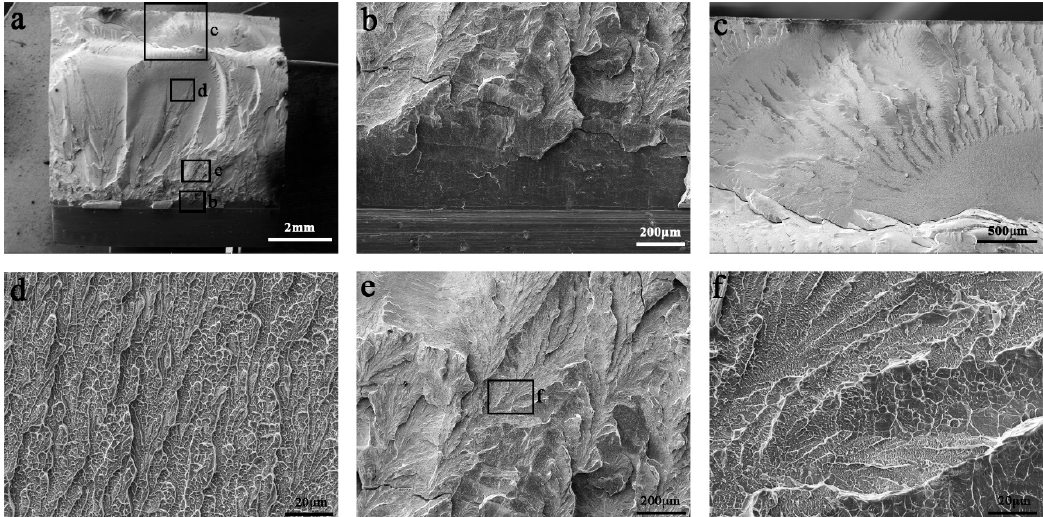
Figure 6. Fractograph morphology of a (Ti 41 Zr 25 Be 28 Fe 6 ) 91 Cu 9 MG after impact toughness test. ( a ) The overall appearance of the fractograph. ( b ) The smooth region and flat zone on the fractograph near the initial notch tip. ( c ) Changed fracture direction and fractograph morphology near the end of the sample. ( d – f ) The vein patterns and viscous features at di ff erent positions of the